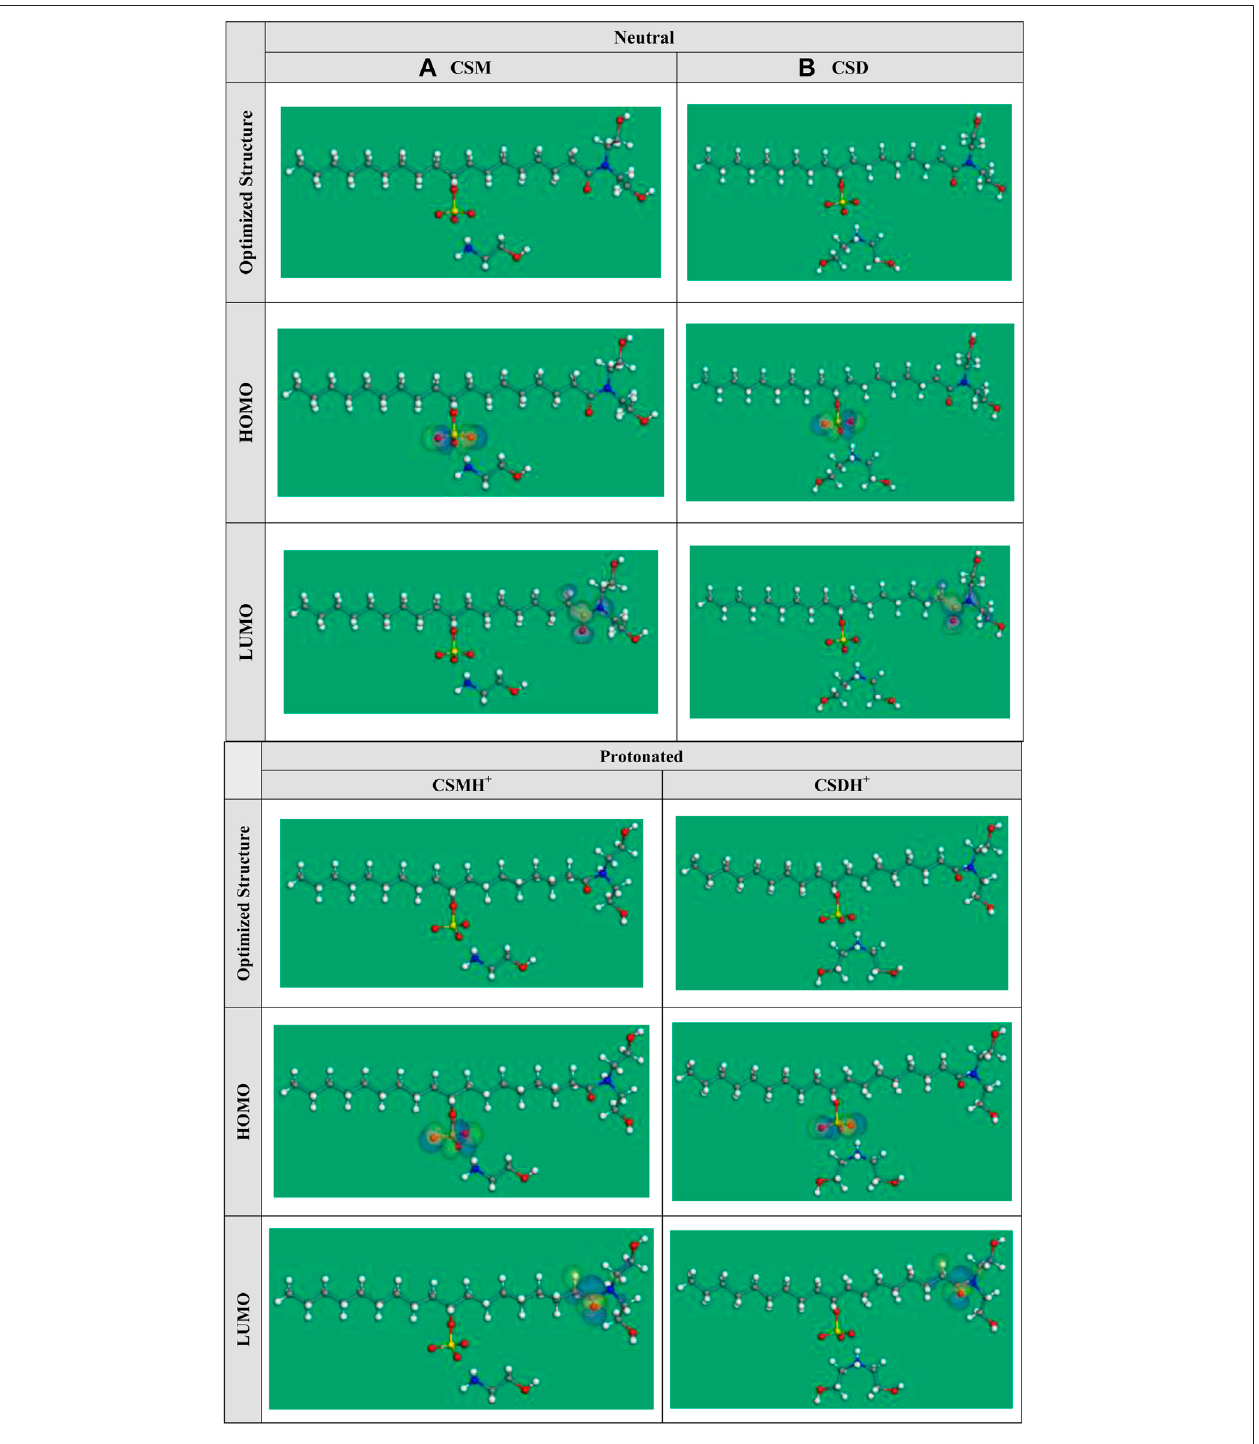
FIGURE 9 | Optimized structure and HOMO and LUMO orbital occupation for the investigated (A) CSM and (B) CSD surfactants in neutral and protonated forms.